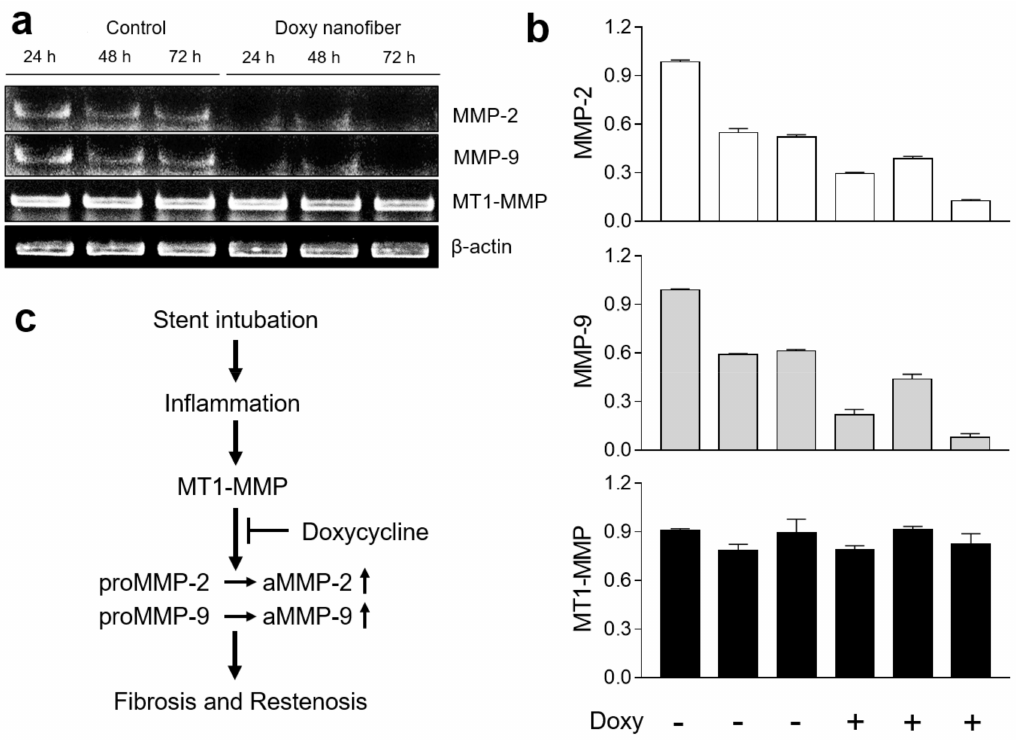
Figure 6. E ff ect of doxy-releasing nanofibers on MMP expression. HT1080 mouse fibrosarcoma cells were placed on the membrane incubated for 24, 48 and 72 h. ( a ) Real-time PCR analysis shows MMP-2, MMP-9 and MT1-MMP mRNA levels. ( b ) Relative MMPs activities were quantified in image J software. Doxy-releasing nanofiber inhibits mRNA levels of the MMP-2 and MMP-9. ( c ) General molecular pathway of MMP expression and resulting tissue fibrosis after a stent intubation. Error bars indicate SEM ( n = 3).